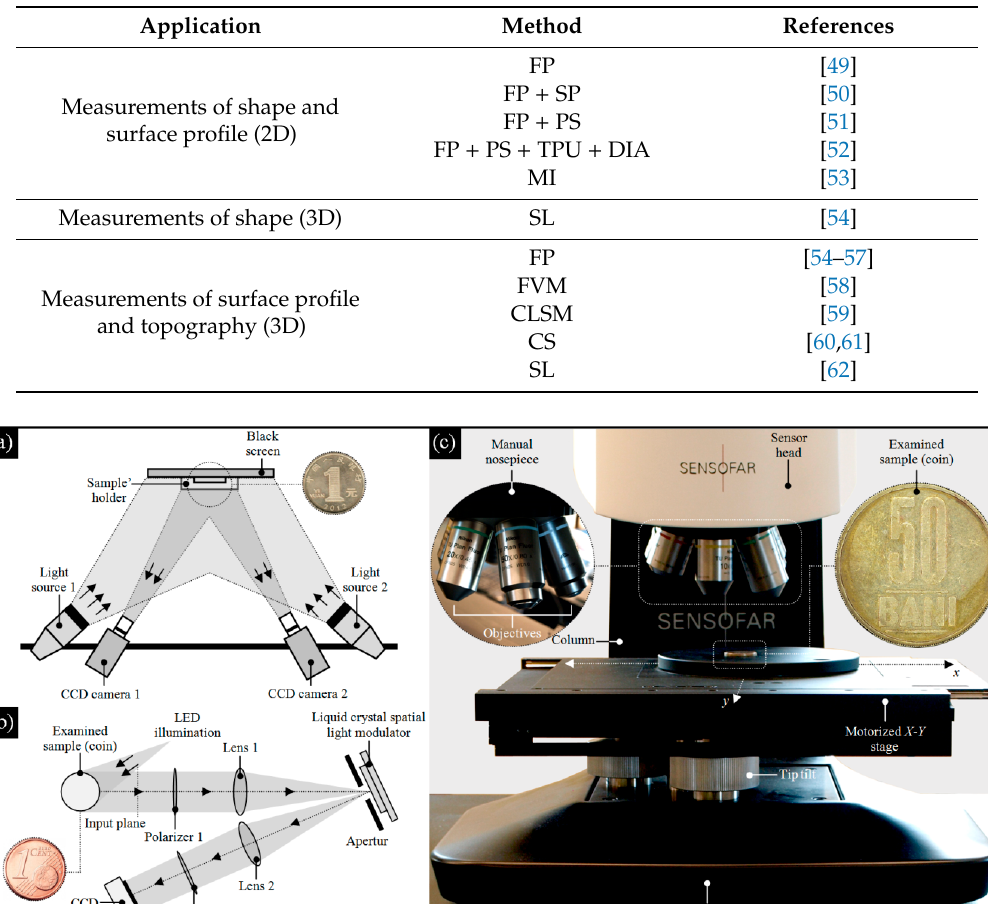
Table 2. Selected optical profilometry-based methods used for the analysis of modern coins.